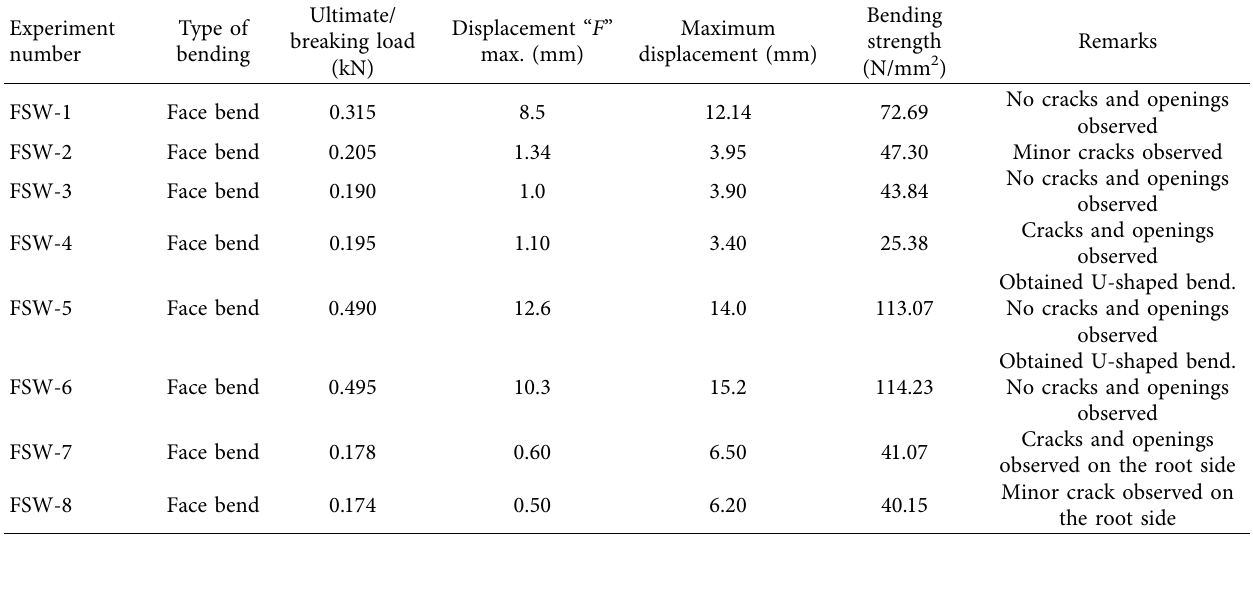
Table 9: Bending test results for weld